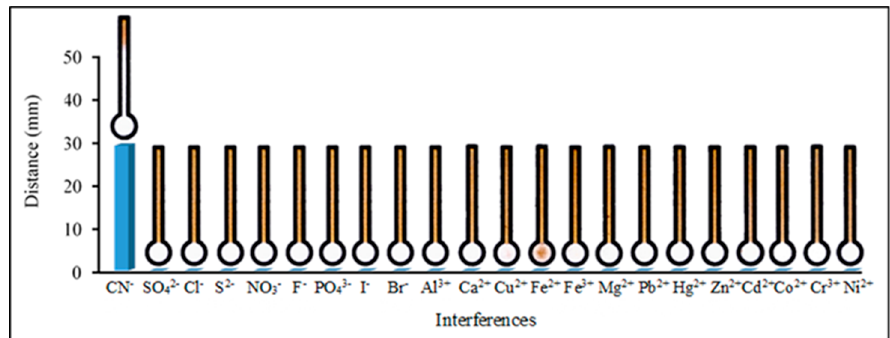
Figure 6. Selectivity of cyanide at 10 mg L − 1 CN − , other anions and cations. The bar shows the white distance on paper-based device for anions and cations detection.